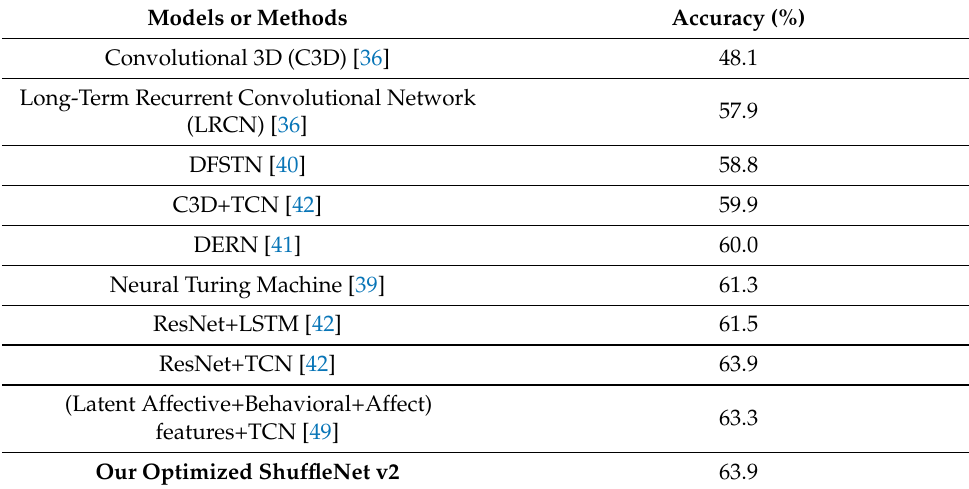
Table 7. Accuracy comparison with other published